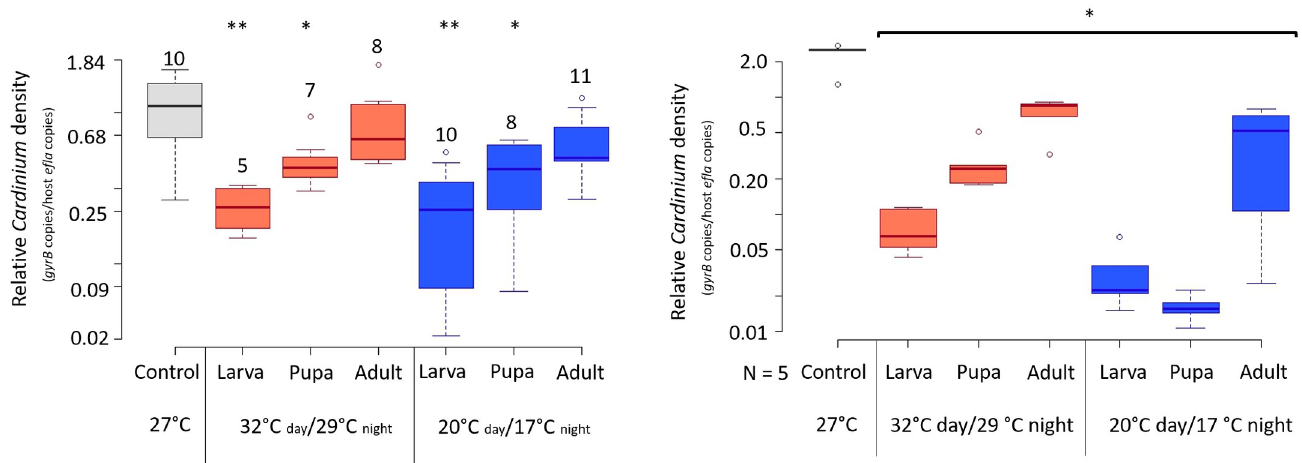
Fig 4. Density of Cardinium infection in adult a) male E . suzannae and b) female E . suzannae . Densities were measured by estimating the amount of single copy Cardinium gyrB genes relative to single copy host ef1-alpa genes with qPCR. N = 5–10 for males (denoted by numbers above whisker plots) and N = 5 for females. Each sample was run with three technical replicates. Color of bars denotes temperature range (grey = 27˚C, red = 32–29˚C, blue = 20–17˚C). Treatments are also separated by the stage at which temperature exposure began. Asterisks denote significant differences compared to the symbiont density at 27˚C.